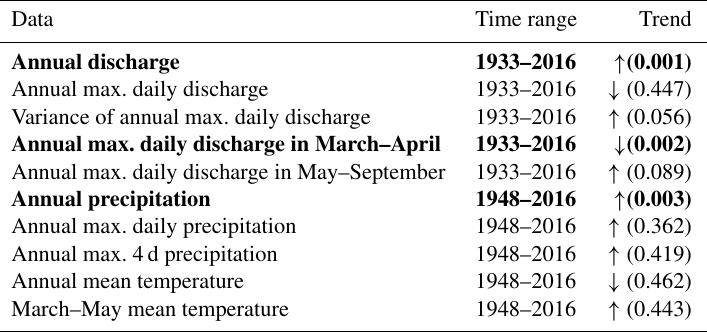
Table 2. Mann–Kendall trend test (two-sided) for hydrological variables. p -values are given in parentheses; bold values are significant at the 5% level. Analyses of trends in variances examine changes in the absolute values of residuals obtained from a linear regression using the Thiel–Sen estimator (Sen,